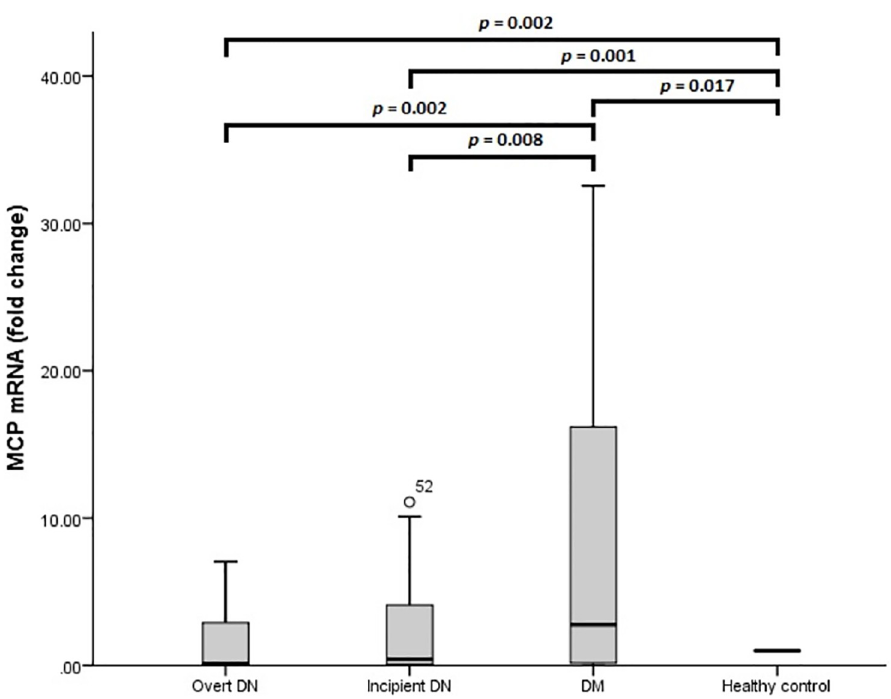
Fig 3. MCP-1 mRNA expression level in blood extracellular vesicles. p value is calculated by the Mann–Whitney U